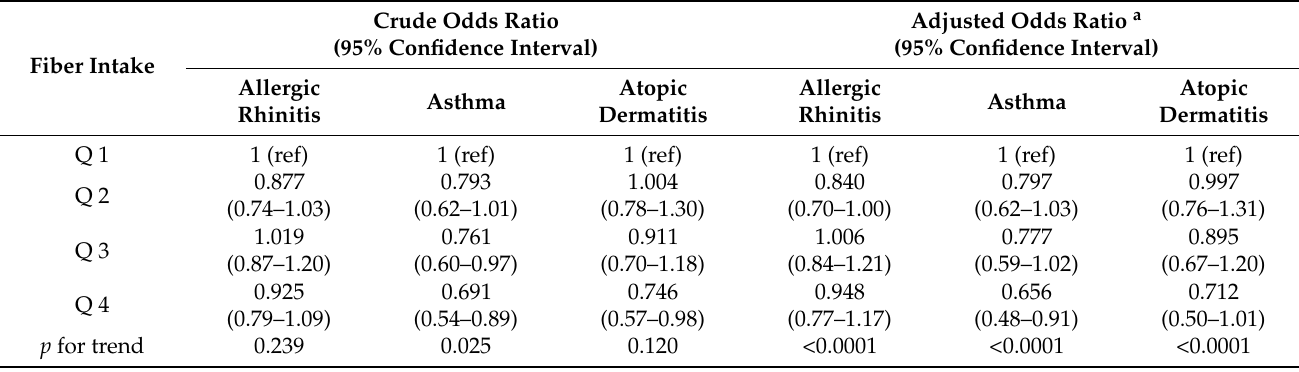
Table 2. Logistic regression analysis of the association between fiber intake and the prevalence of allergic diseases.